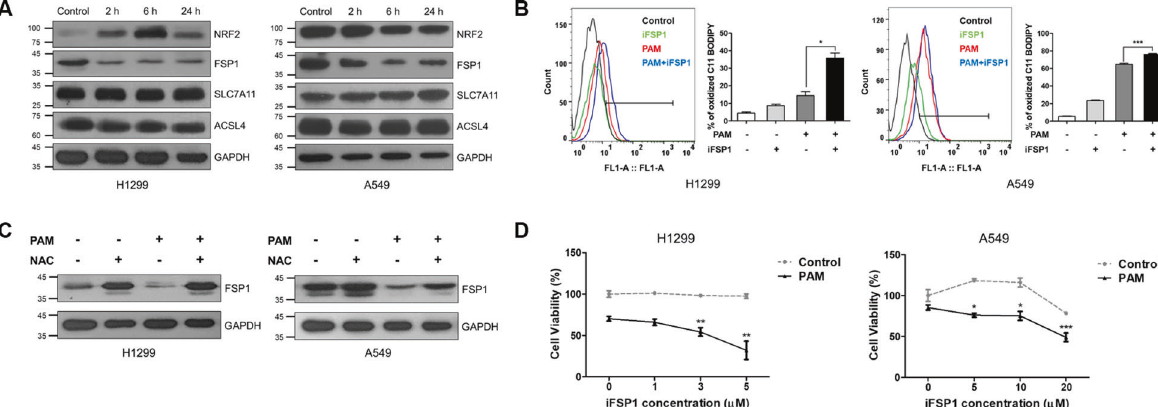
Fig. 4 Plasma-activated medium regulates ferroptosis via NRF2/FSP1 signaling. The plasma exposure conditions were 1.9 standard liter per minute (SLM), 7 W input power and 180 s. A Western blot analyses of expression of NRF2, FSP1, SLC7A11, and ACSL4 were detected by Western blotting. GAPDH was used as a loading control. B Lipid ROS levels were detected using BODIPY 581/591 C11 dye. H1299 and A549 cells were treated with PAM (180 s) or 2 μ M ferrostatin-1 for 2 h. C The protein levels of FSP1 in H1299 and A549 cells following PAM (180 s) or 2 mM NAC treatments. GAPDH was used as a loading control. D The cell viability was measured using MTT assay. H1299 and A549 cells were treated with indicated concentration of FSP1 inhibitor (iFSP1) with or without PAM (180 s). Data represent the mean ± SD from three